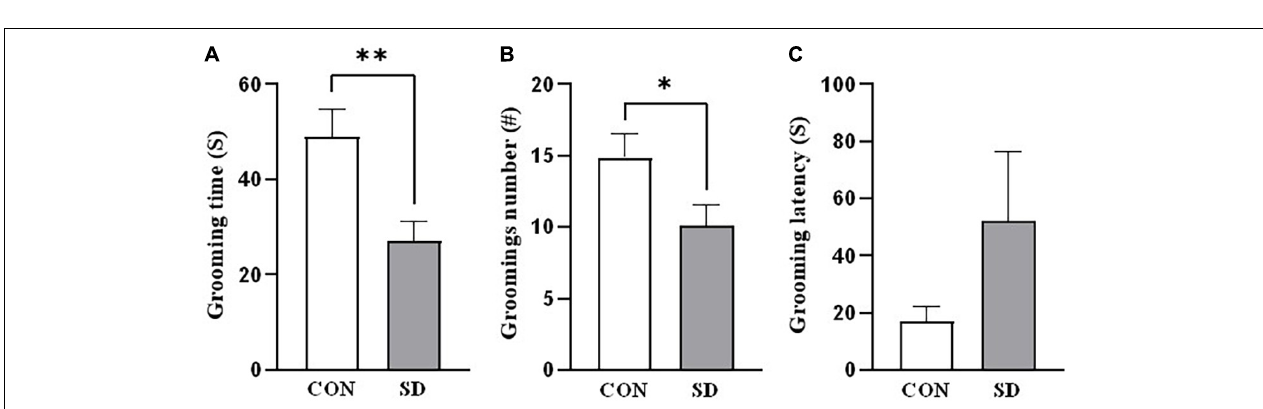
FIGURE 1 | Growth curve and anxiety-like behavior. Rats’ weight was measured daily throughout the sleep deprivation protocol (A) . Lines represent the means of weight in grams (g) ± SD. Rats were assessed for anxiety-like behavior at PND33 using EPM test, time spent in open arms (B) , number of open-arm entries (C) , and number of close-arm entries (D) . Bars are means ± SD, n = 6–8 rats per group. Data were analyzed using two-tailed unpaired t -test. ( ∗ ) Significantly different at p < 0.05. PND: Postnatal day. Group designations: control (CON), sleep deprivation (SD).